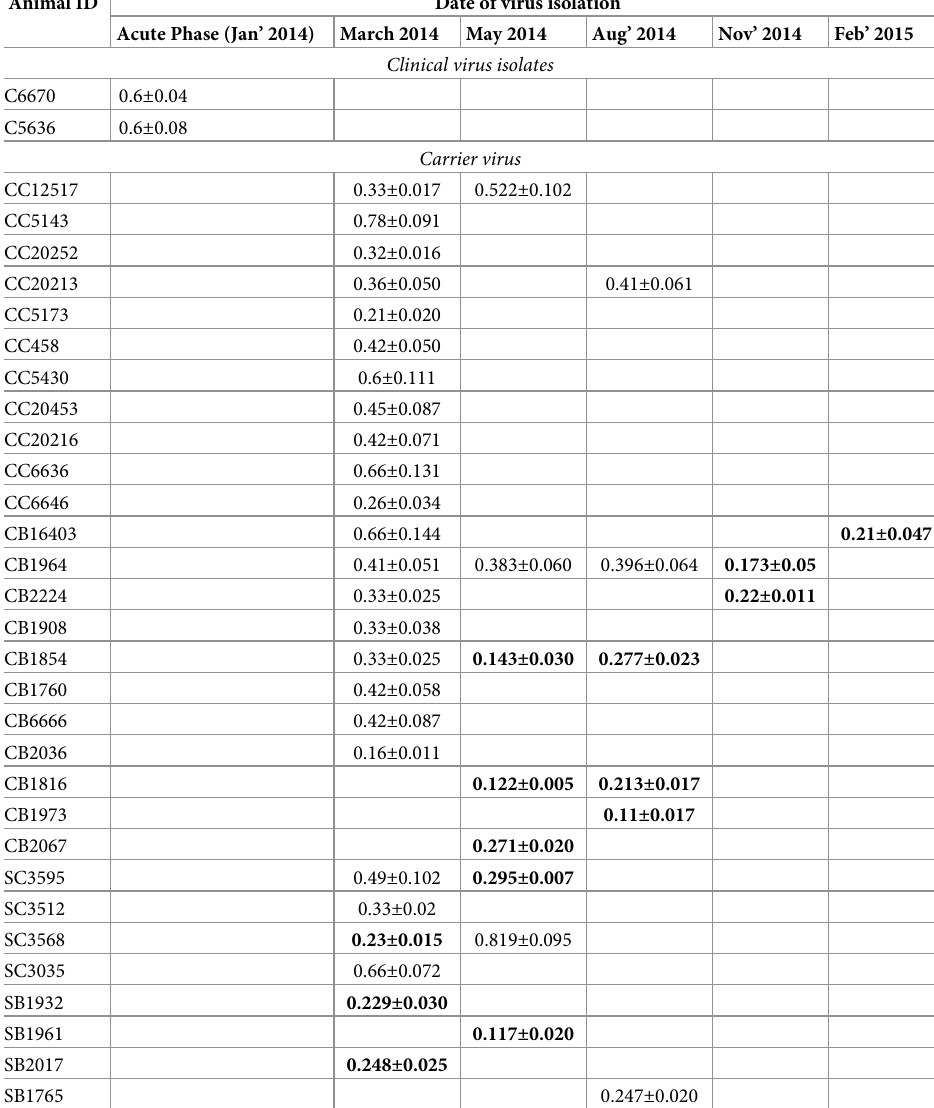
Table 5. One way antigenic relationship (r1-value) of the outbreak and carrier virus isolates with the currently used vaccine strain, O/IND/R2/1975, as determined by 2D-VNT assay. Values are expressed as mean ± standard deviation (s.d). Values < 0.3 are in bold, indicating poor vaccine protection against that